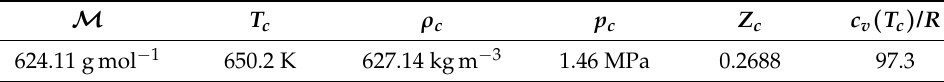
Table 2. Thermodynamic properties of PP11 (C 14 F 24 ): molecular weight density ρ c , pressure p c , compressibility factor Z c , and ratio of ideal-gas specific heat at a constant volume at the critical point over the gas constant c v ( T c ) / R . M T c ρ c p